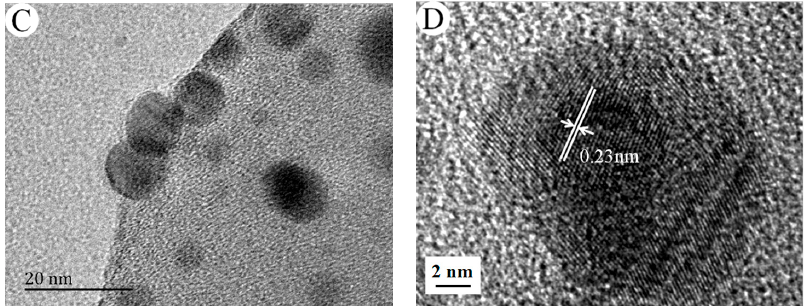
Figure 12. Representative TEM images of nAg@PSA composite nanospheres obtained from PSA0 nanospheres with different scale bars ( A ) 200 nm, ( B ) 100nm, ( C ) 20 nm, ( D ) 2 nm.